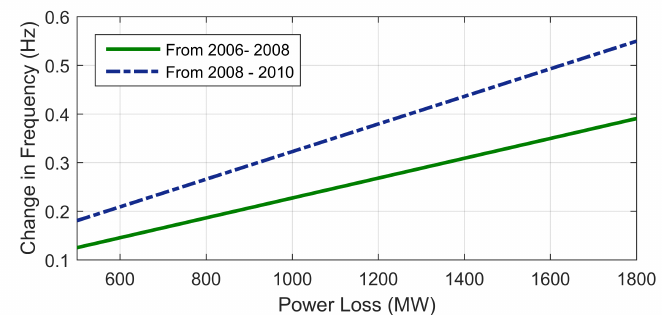
Figure 2. Increase in frequency changes in Electricity Reliability Council of Texas (ERCOT) connection due to generation loss